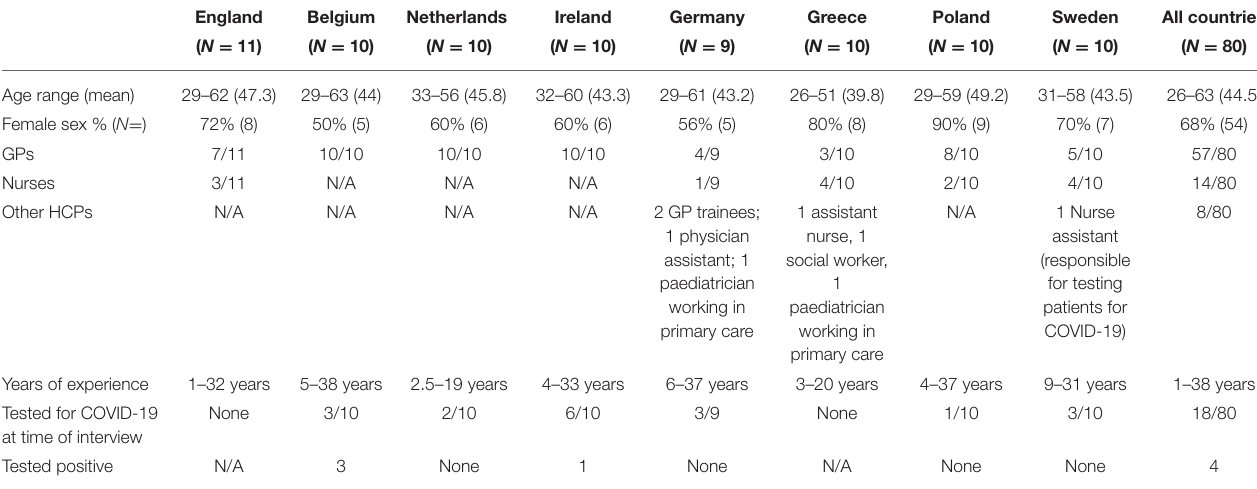
TABLE 1 | Characteristics of participants by country.